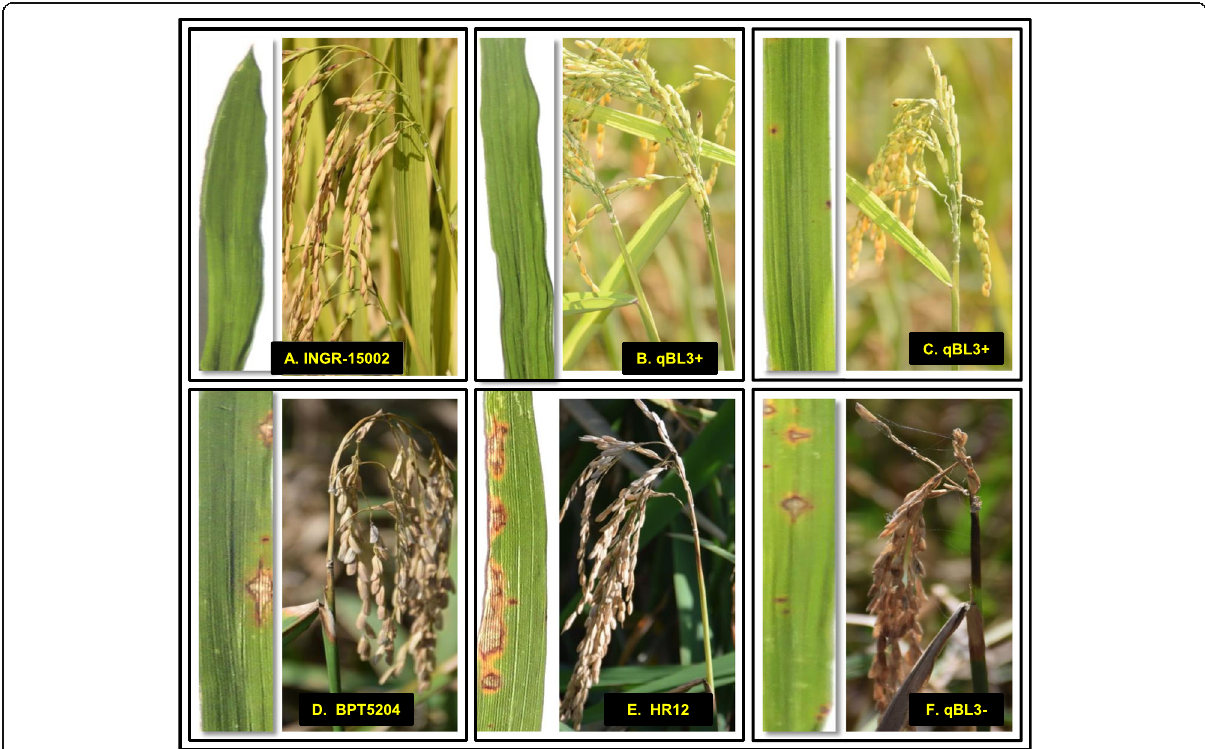
Fig. 3 Phenotypic evaluation of parent ( a INGR15002); BC2F3 promising entries ( b & c having qBL3; plant numbers, 31 R & 78 R); along with susceptible checks ( d BPT5204; e HR12); f is the BC2F3 line that does not have qBL3 ; the plants containing qBL3 showed better response than the susceptible checks BPT5204 & HR12. The right panel of each picture corresponds to leaf blast and left panel to neck